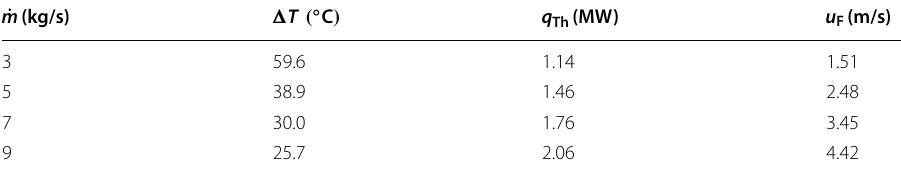
Table 7 Key thermodynamic properties for various ˙ m (kg/s) quoted to three significant figures